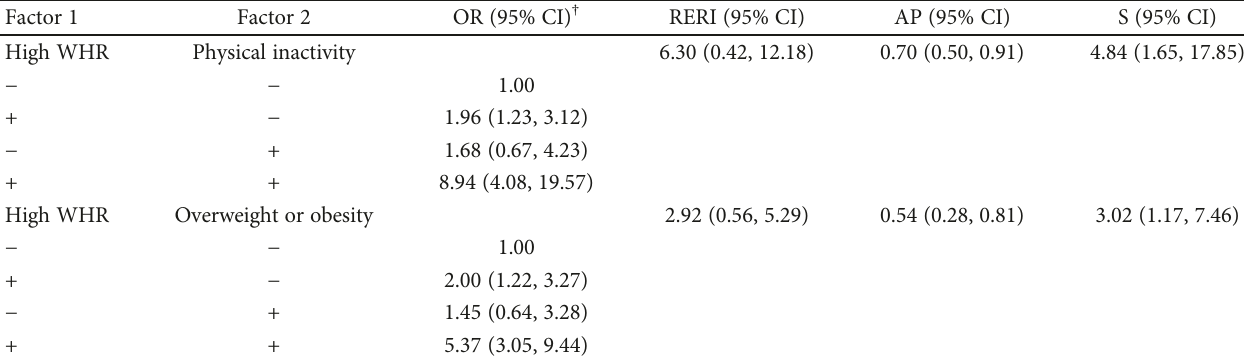
Table 5: Interactions of risk factors for prediabetes among the elderly in rural